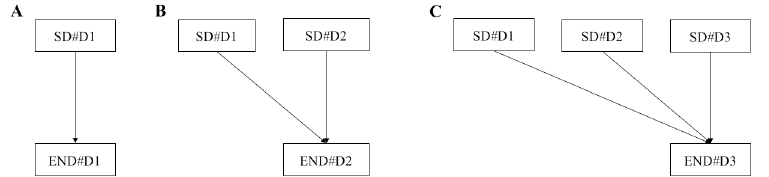
Fig 1. Statistical association between SBP SD and primary outcomes. Daily SBP SD values were investigatedfor END#D1(A), END#D2(B), and END#D3 (C). In multivariableanalysis,the interactionterm SD#D1 × SD#D2 was includedin model B and SD#D1 × SD#D2, SD#D1 × SD#D3, SD#D2 × SD#D3, and SD#D1 × SD#D2 × SD#D3 were includedin model